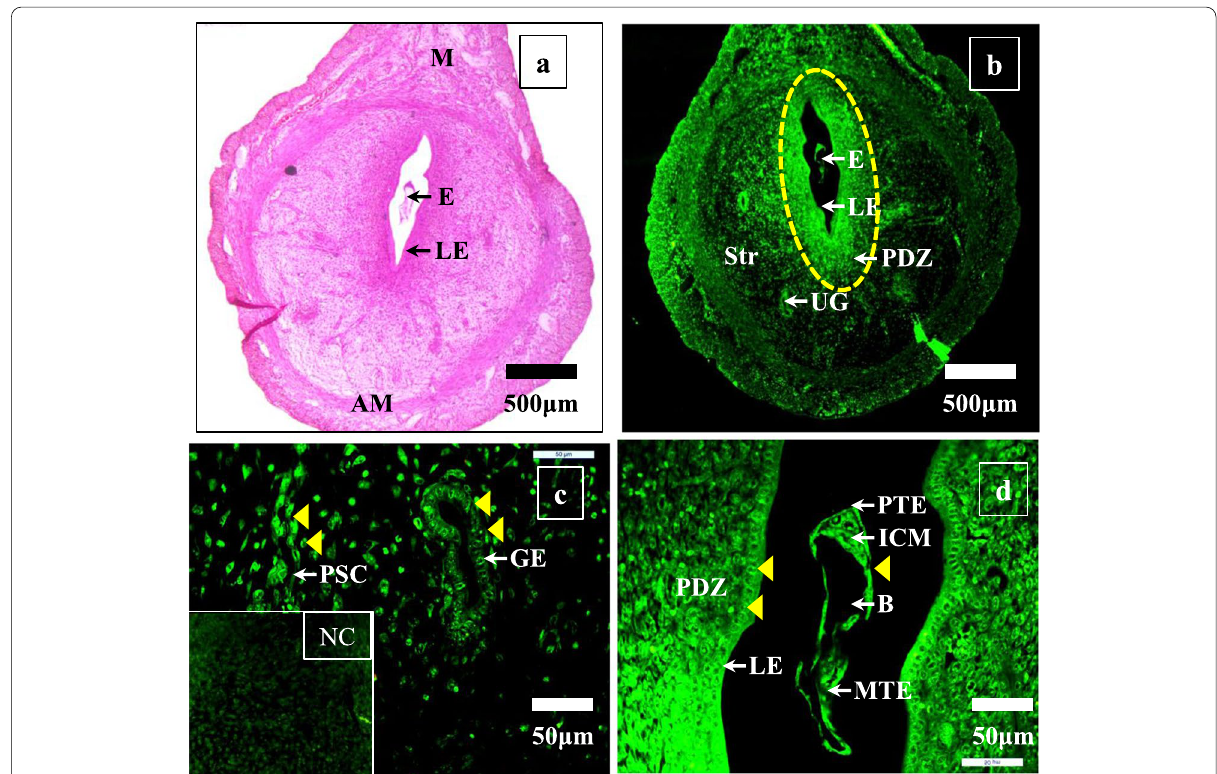
Fig. 3 Immunofluorescence of KLF5 on D5 mice uterus using FITC-conjugated antibody. The KLF5 protein was localized in the luminal epithelium (LE), glandular epithelium (GE) of uterine glands, embryo (E), and proliferating stromal cell (PSC) of the primary decidual zone (PDZ). The arrowhead indicates the expression. Original magnification: a 5 MTE, mural trophectoderm, M, mesometrial pole; AM, antimesometrial pole, NC, negative